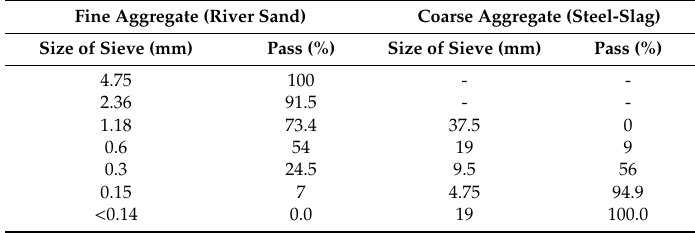
Table 2. Particle size distribution of fine aggregate and coarse aggregate.